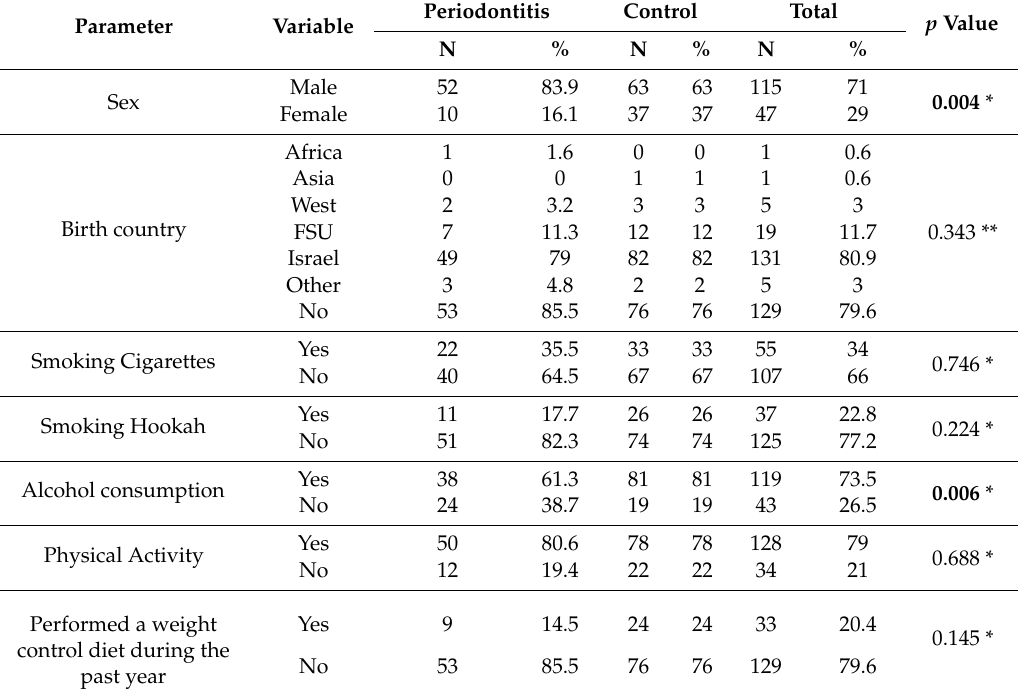
Table 1. Demographics and health-related habits of the study